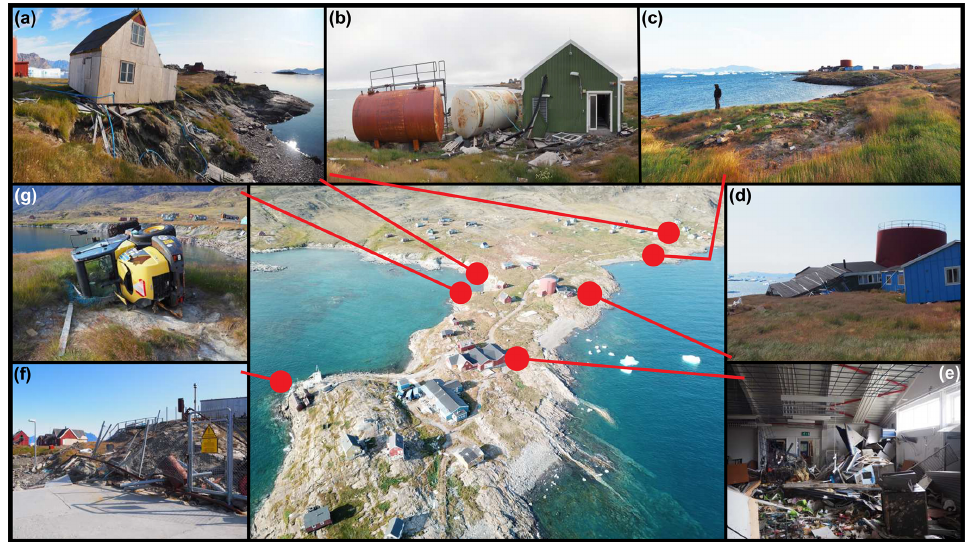
Figure 8. Examples of infrastructure damage caused by the 2017 tsunami in Nuugaatsiaq. (a) Wooden house removed by wave from point foundation transported several dozens of metres. (b) Fuel tanks washed away from concrete frames and pushed towards power plant. Note large accumulation of litter and tsunami deposits around and inside the buildings; (c) site of former building position, which was destroyed and swept away by the tsunami. Note broken wooden point foundations, media connections, and erosional gullies. (d) Smashed and collapsed wooden school building moved towards major water tank. (e) Interior of local shopping centre passed by tsunami. Note large amounts of litter and rotting food supplies and twisted and bowed metal frame construction. (f) Partly torn metal fence around fuel storage site which acted as a trap for litter transported by tsunami; (g) example of heavy machine knocked over by